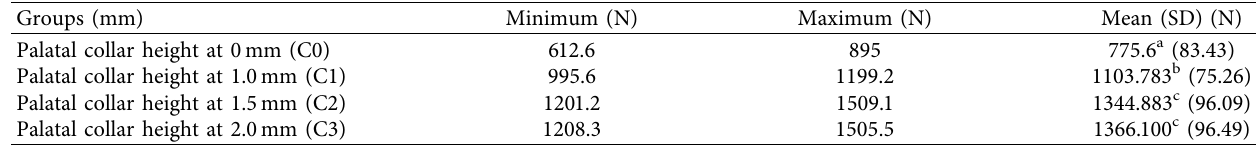
Figure 10: (a) Scanning electron microscopic images of the fractured metal-ceramic crowns at 100x magnification showed the presence of mirrors, hackles and wake hackles. (b) Scanning electron microscopic images of the fractured metal-ceramic crowns at 100x magnification showed the presence of mirrors, hackles and wake hackles. Table 3: Descriptive statistics of fracture load values (N).